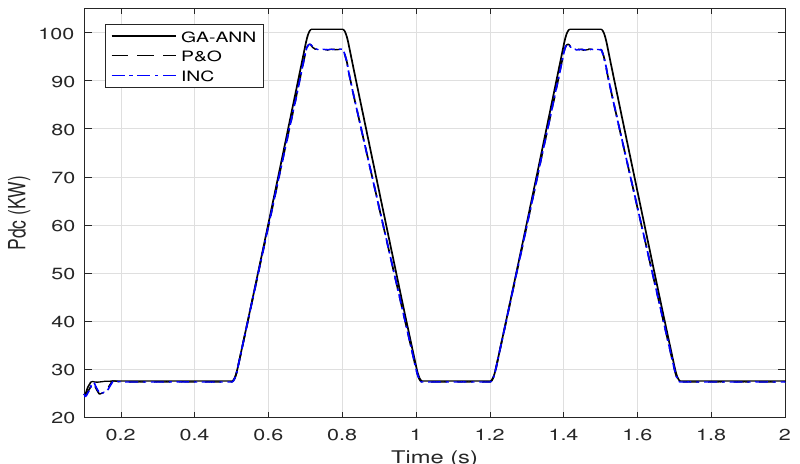
Figure 20. A Comparison of the output DC power of the PV array using GA-ANN, P&O and INC MPPT methods for a dynamic irradiance change based on EN50530 standard.